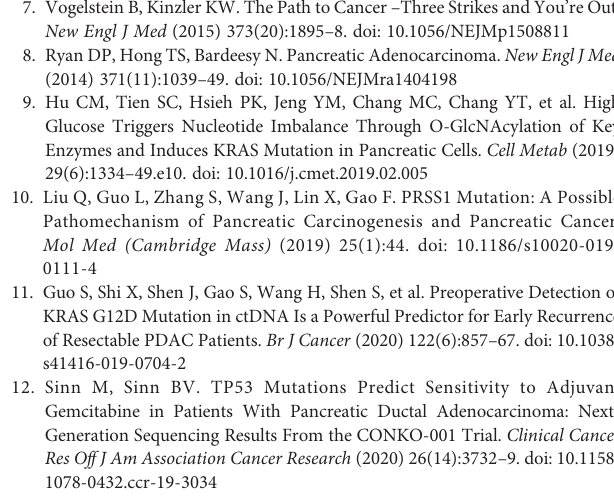
Supplementary Figure 2 | Mutational signature of PDAC. (A) Three mutational signatures identi fi ed by NMF analysis and their highly similar reported COSMIC signatures. (B) Comparison of diabetes mellitus status in the three groups of PDAC patients (n=302). (C) Comparison of mutational spectrum between PDAC patients with (n=80) and without (n=216) diabetes mellitus. Supplementary Figure 3 | Somatic mutation of PDAC. (A) The correlation between somatic mutations and clinical variables in PDAC (n=302). (B) Overall survival analysis of above 247 PDAC patients with (n=144) and without (n=103) TP53 mutations. (C) Overall survival analysis of above 247 PDAC patients with (n=39) and without (n=208) SMAD4 mutations. (D) Overall survival analysis of above 247 PDAC patients with (n=29) and without (n=218) CDKN2A